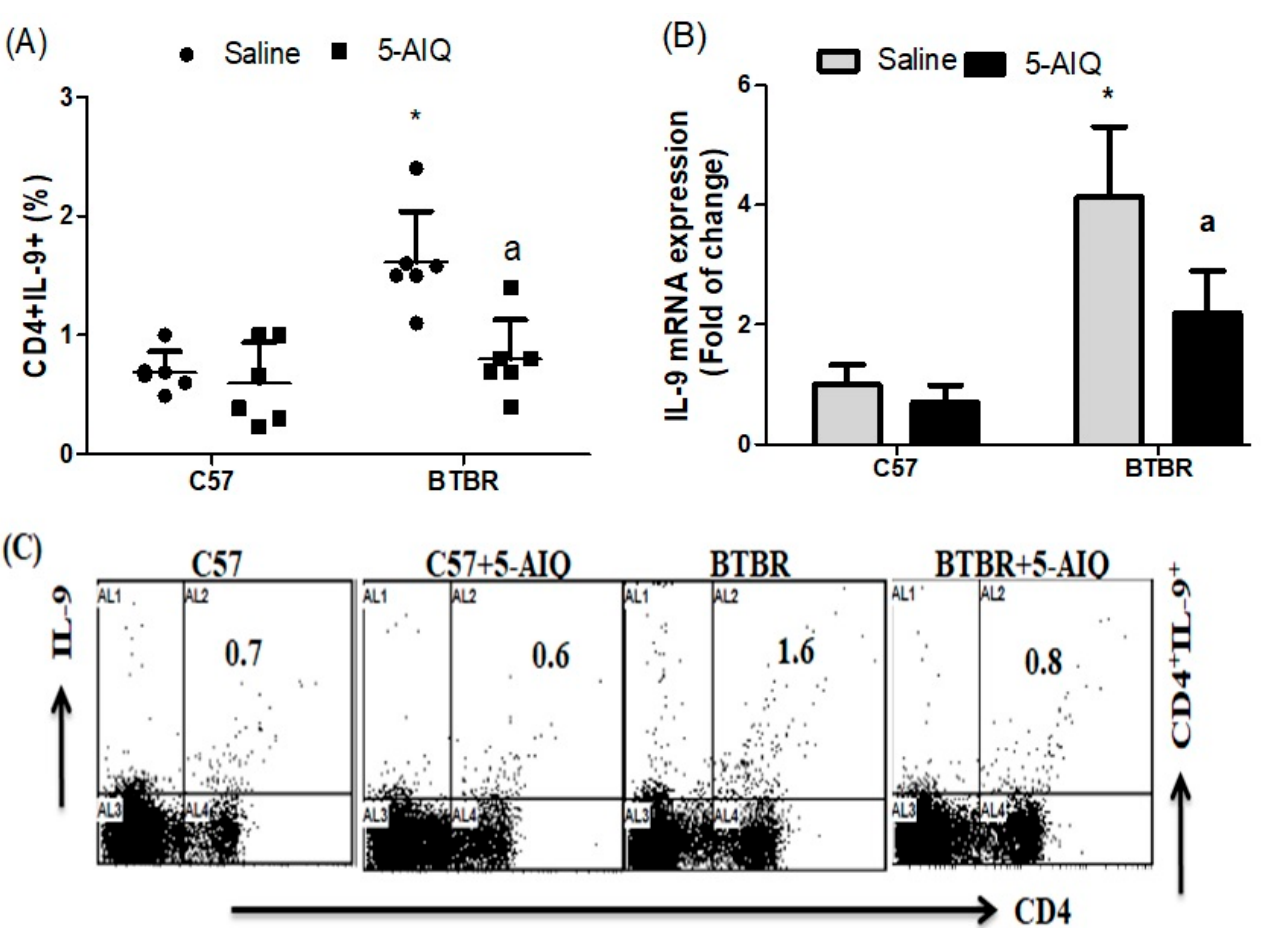
Figure 5. Effects of 5-AIQ on expression of IL-9 in C57 and BTBR mice. ( A ) Flow cytometry analysis of intracellular IL-9-producing CD4+ T cells from mouse spleens (Strain effect, F(1,20) = 17.33, p < 0.0005; Treatment effect, F(1,20) = 11.3, p < 0.0031, Treatment x Strain effect, F(1,20) = 7.31, p < 0.0147) and ( B ) RT-qPCR analysis of levels of IL-9 mRNA from mouse brain tissue (Strain effect, F(1,20) = 251.9, p < 0.0001; Treatment effect, F(1,20) = 26.00, p < 0.0001, Treatment x Strain effect, F(1,20) = 16.13, p < 0.0007). ( C ) Cells were gated on forward-side scatter dot plots; the dot plots represent the percentages of CD4+IL-9+ cells. Bar graphs represent the percentage of CD4+IL-9+ population. The control C57 and BTBR mice received saline intraperitoneal injection. Treated BTBR and C57 mice received 5-AIQ (1.5 mg/kg) via intraperitoneal injection once daily for ten days. The results are shown as the means ± SD, n = 6, each group; * p < 0.05 compared with saline-treated C57 mice; a p < 0.05 compared with saline-treated BTBR mice.